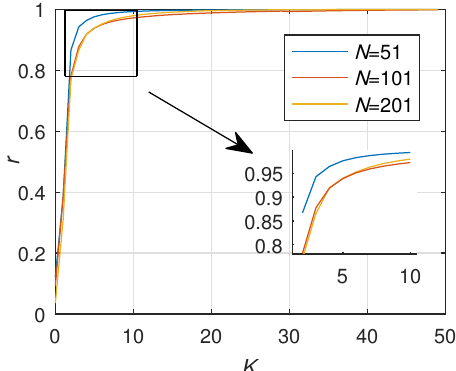
Figure 7. The stability of the weighted undirected network when N is